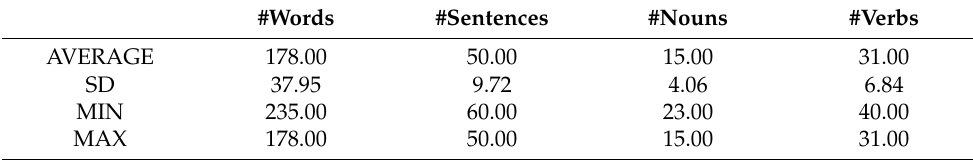
Table 1. Dataset